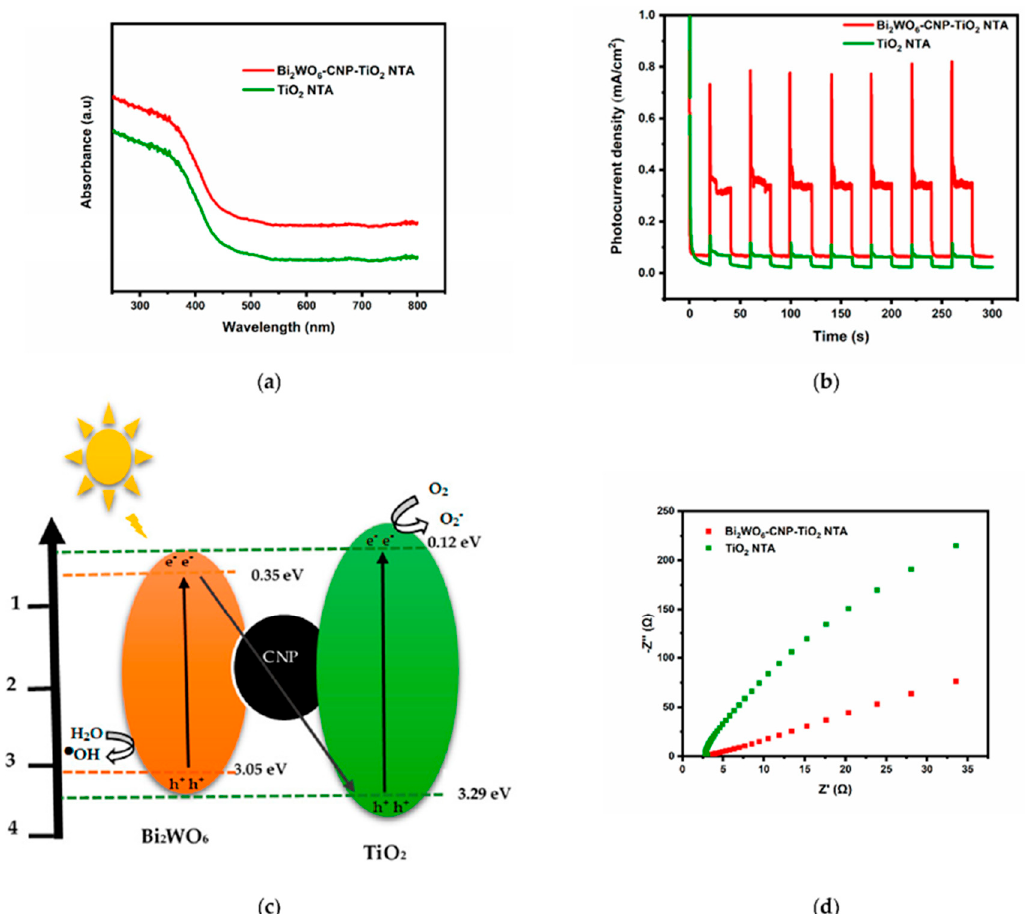
Figure 8. ( a ) UV-Visible diffuse reflectance spectra TiO 2 NTA Bi 2 WO 6 -CNP-TiO 2 NTA; ( b ) photocurrent responses of TiO 2 NTA and Bi 2 WO 6 -CNP-TiO 2 NTA in 0.1 M Na 2 SO 4 ; ( c ) schematic diagram of Z-scheme mechanism of Bi 2 WO 6 -CNP-TiO 2 NTA electrode; ( d ) Nyquist plot TiO 2 NTA and Bi 2 WO 6 -CNP-TiO 2 NTA photoanodes in 5 mM [Fe(CN) 6 ] 3 − /4 − in 0.1 M KCl (pH 7). Reproduced with permission [70].